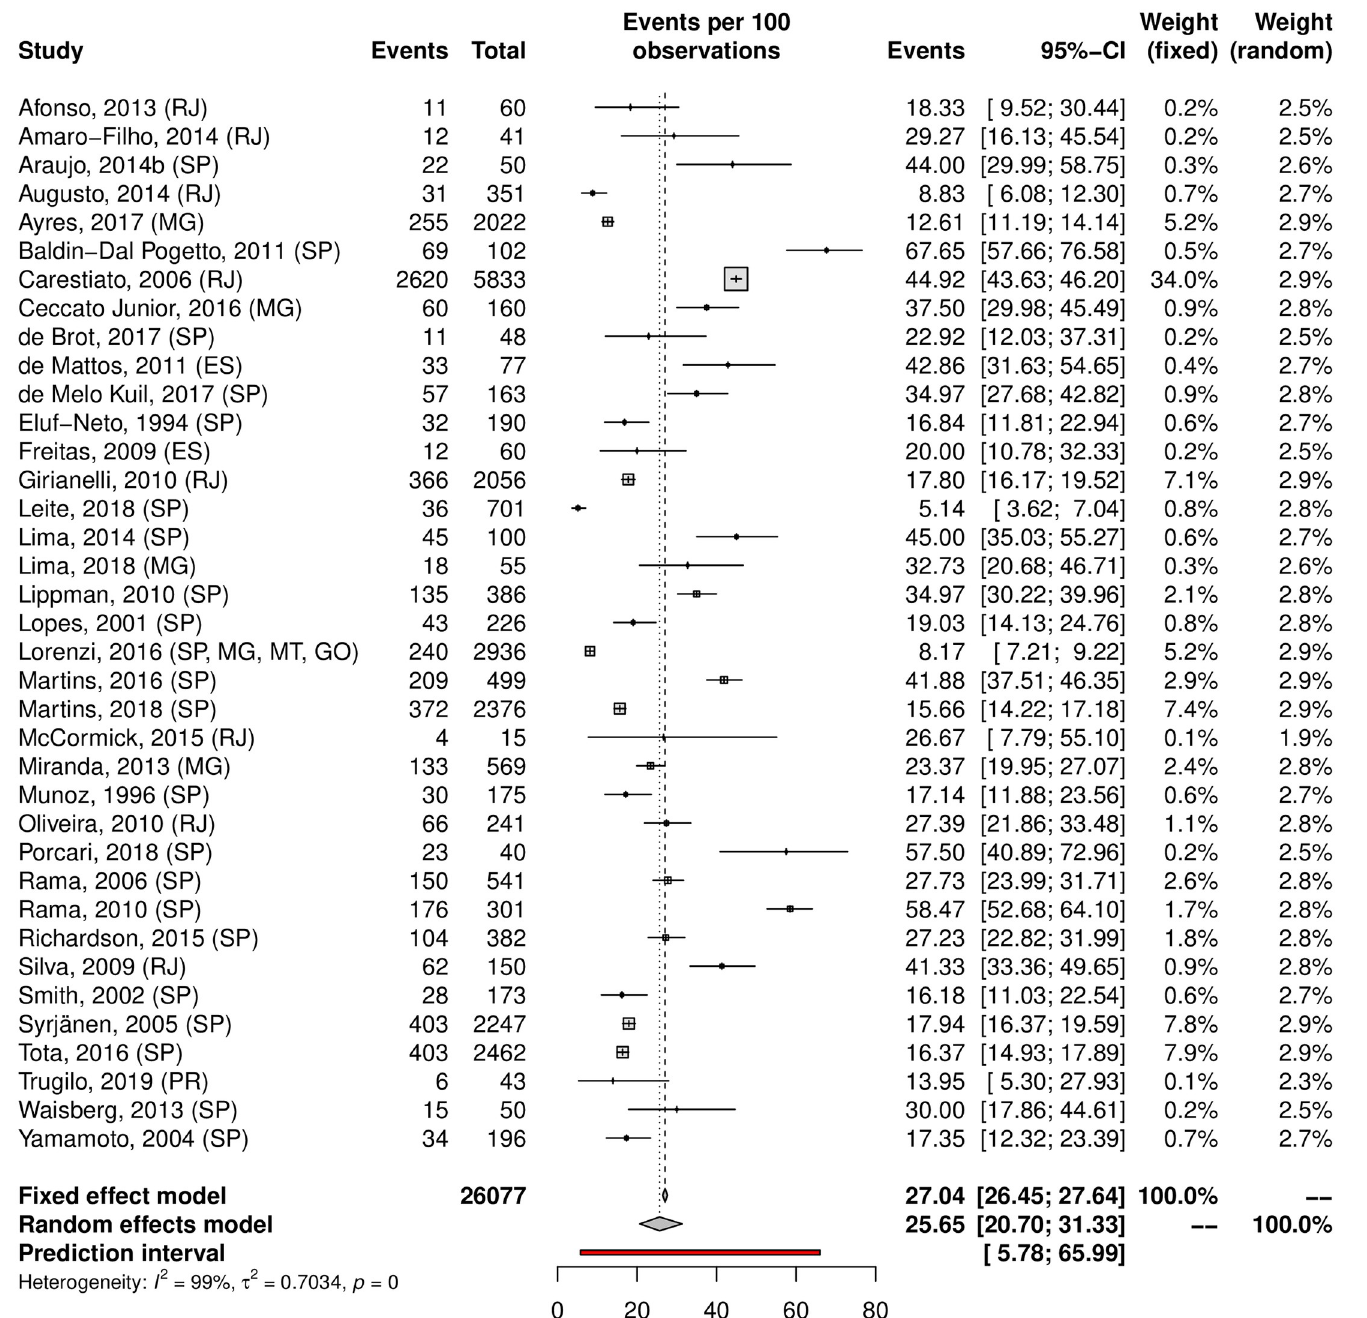
Fig 8. Prevalence of cervical HPV in the Southeast region of Brazil. Forest plot of a metanalysis of studies reporting prevalence of cervical infection by HPV in the Southeast region of Brazil.